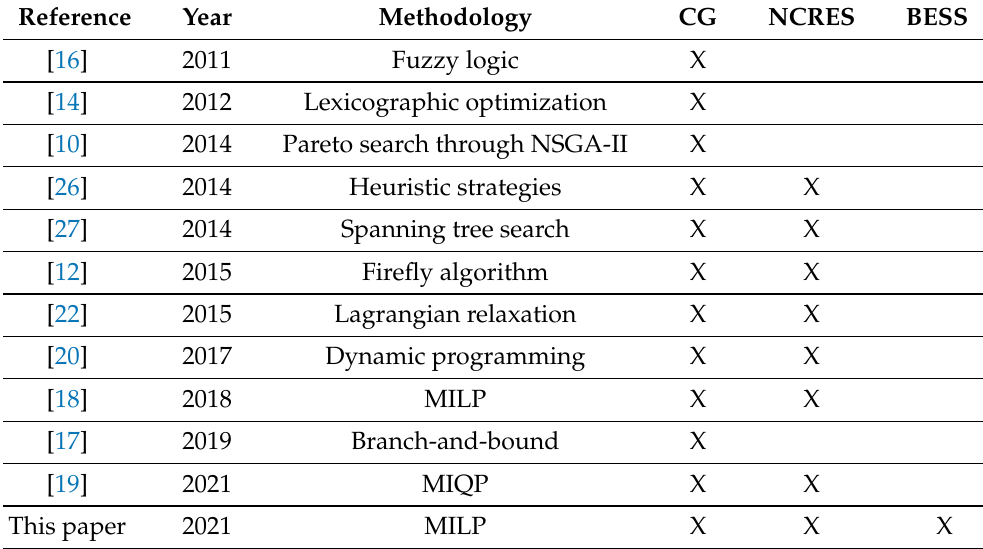
Table 1. Optimal generation start-up